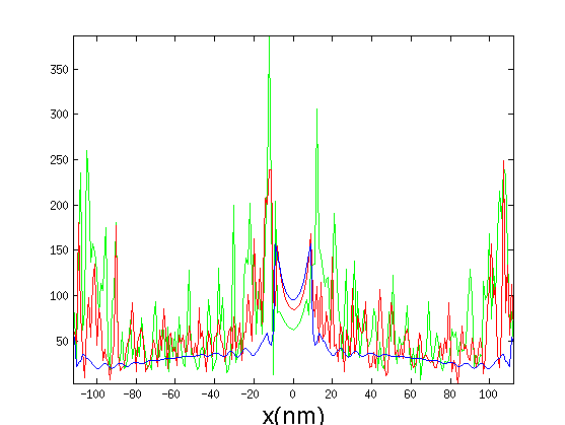
2 inside the E Figure 9: Intensity of the electric field | | nanoantenna ( — : biosensor with smooth surface, — : biosensor with rms roughness 0.82 nm and — : biosen- sor with rms roughness 1.41 nm; the gap between the two 10 to x = 10 nm) nanorods is from x = −